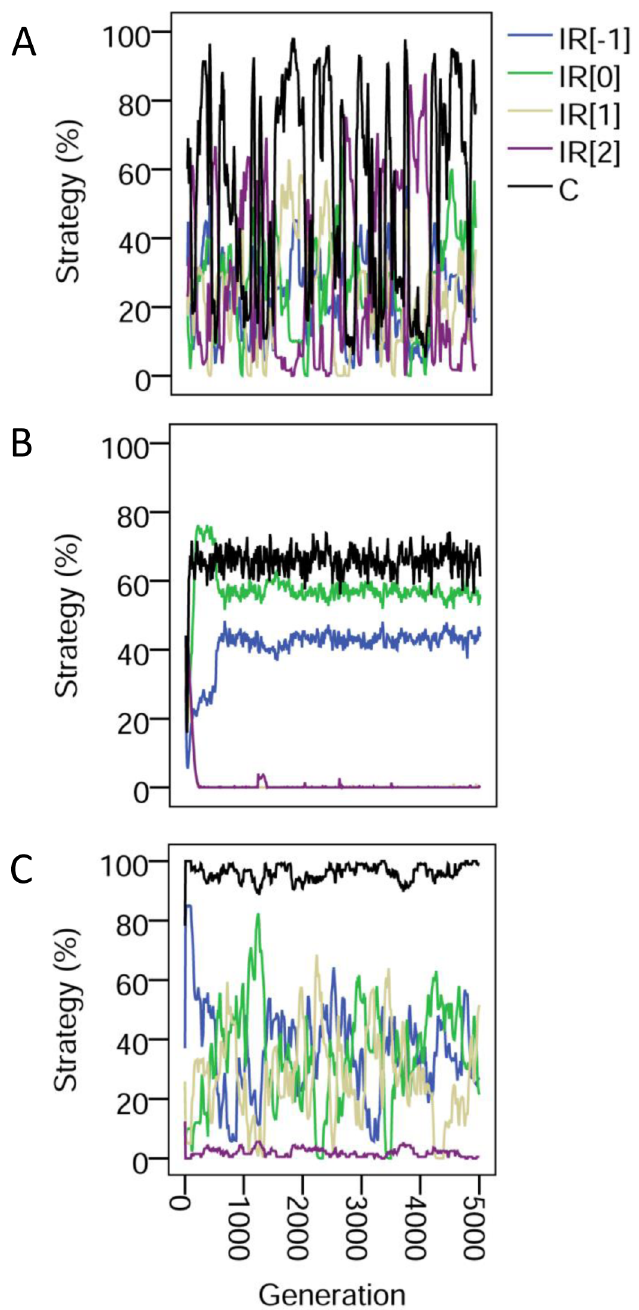
Fig 3. Dynamics of image scoring and partner choice. The evolutionary dynamics of indirect reciprocity strategies for (A) pure image scoring with random assignment; (B) with phenotypic defectors; (C) with partner choice. The first of 10 simulations is shown in each case. Strategies are labelled as IR[ k ] where k is the strategy threshold. Thus k = -1 denoted individuals that cooperated unconditionally; k = 0 strategists cooperated provided their partner had never played or had cooperated; k = 1 strategists cooperated provided the partner had cooperated; and k = 2 strategists never cooperated. C is cooperation, plotted as the proportion of cooperative